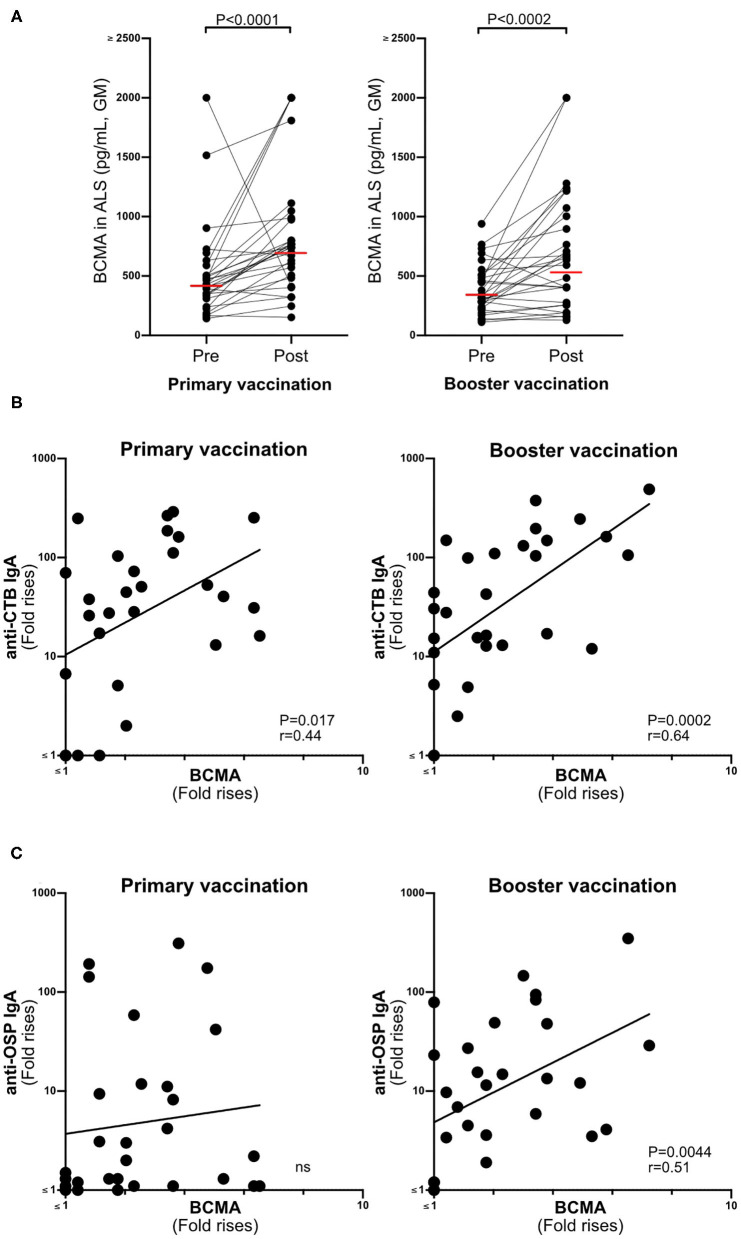
BCMA responses in ALS specimens correlate with Dukoral® ALS vaccine responses in Swedish volunteers. (A) Concentrations of BCMA (pg/mL) in ALS specimens were quantified by ELISA in 29 individuals before (pre) and after (post) primary and booster Dukoral® vaccination. Horizonal bars represent geometric mean values. (B) Correlation between the magnitudes of ALS CTB IgA responses and ALS BCMA fold rises following primary and booster Dukoral® vaccinations. (C) Correlation between the magnitudes of ALS OSP IgA and ALS BCMA responses following primary and booster Dukoral® vaccinations. Each symbol represents one individual.